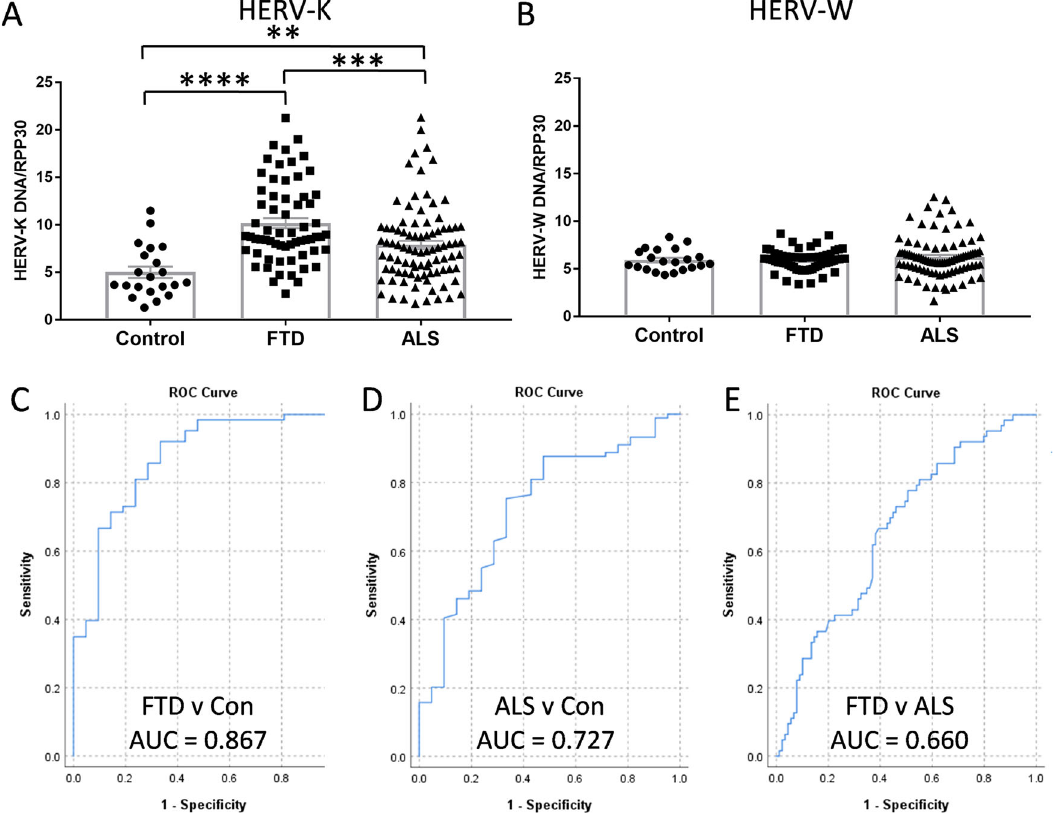
Fig. 2 A comparison of HERV-K levels in FTD and ALS. A HERV-K env levels in FTD ( n = 63), ALS ( n = 89) and control ( n = 21) serum as measured by ddPCR. B HERV-W env levels in FTD ( n = 63), ALS ( n = 89) and control ( n = 21) serum as measured by ddPCR. (C) HERV-K ROC curve for FTD vs. Con. D HERV-K ROC curve for ALS vs. Con. E HERV-K ROC curve for FTD vs. ALS. Data represent individual patients, mean and SE as error bars, ** P < 0.01, *** P < 0.001, **** P <